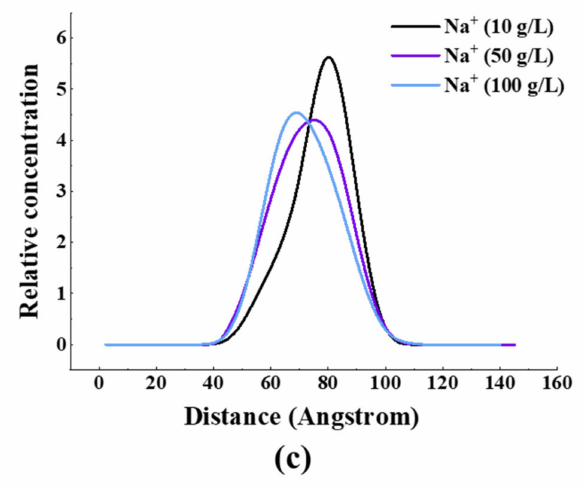
Figure 5. Distribution of cations in different APG foams. ( a ) CaCl 2 , ( b ) MgCl 2 , and ( c ) NaCl.